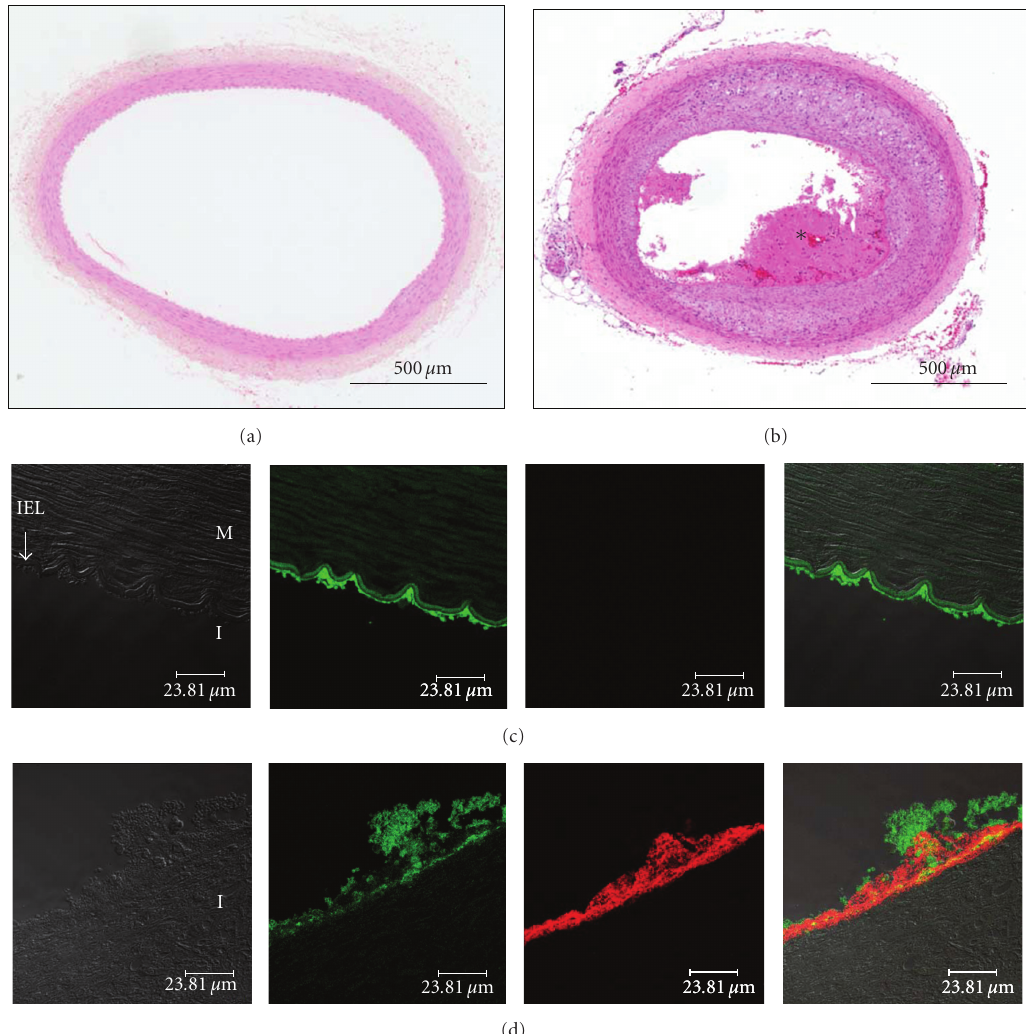
Figure 5: Light and immunofluorescence microphotographs of thrombus on rabbit femoral arteries. Representative light and immunofluorescence microphotographs of thrombi that developed in normal femoral artery 15 minutes after balloon injury and in atherosclerotic neointima from rabbits on 0.5% cholesterol diet. Whole images of arterial sections of normal artery (a) or atherosclerotic artery (b) 15 minutes after balloon injury. The size of thrombus significantly di ff ers between normal artery thrombus and atherothrombus ( ∗ ). The normal artery thrombus is too small to recognize. Hematoxylin eosin stain. Rows (c, d) show di ff erential interference contrast, fluorescein isothiocyanate-labeled GPIIb/IIIa (green), Cy3-labeled fibrin (red), and merged immunofluorescent images. Areas with colocalized factors are stained yellow. Thrombi on normal intima are composed of small aggregated platelets (c), whereas those on atherosclerotic neointima comprise platelets and fibrin (d). I, intima; M, media; IEL, internal elastic lamina (from Yamashita et al. [28] with